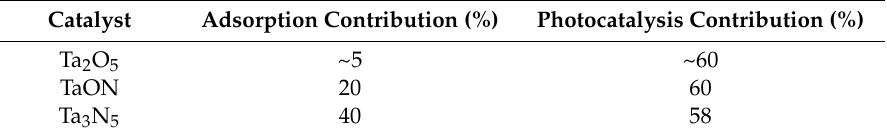
Table 1. Contribution of adsorption and photocatalysis toward the overall conversion of MB by Ta 2 O 5 , TaON, and Ta 3 N 5 . Significant improvement in adsorption-contribution toward MB removal can be attributed to the better anchorage provided to MB molecules by nitrided catalysts due to the increased atomic defects.